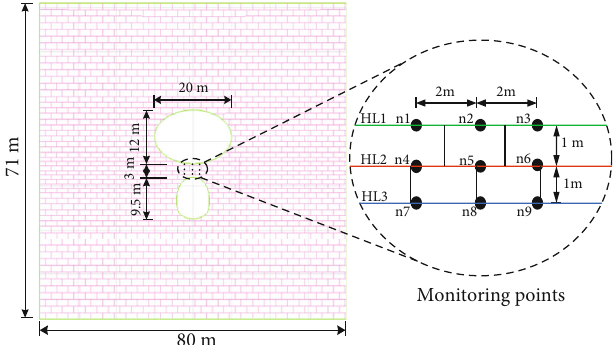
Figure 2: Simulation calculation model and measuring point